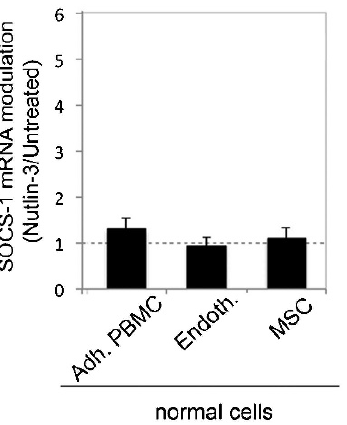
Figure 3 - Lack of transcriptional modulation of SOCS-1 by Nutlin-3 in normal cells. Normal adherent PBMC, endothelial cells, and MSC were exposed to Nutlin-3 (10 m M). Levels of SOCS- 1 mRNA were analyzed by quantitative RT-PCR. The results are expressed as the fold increase in SOCS-1 modulation by Nutlin-3 after 24 hours of treatment with respect to the control untreated cultures (set to 1) (hatched line). Data are reported as the mean ¡ SD of the results from at least three experiments, each performed